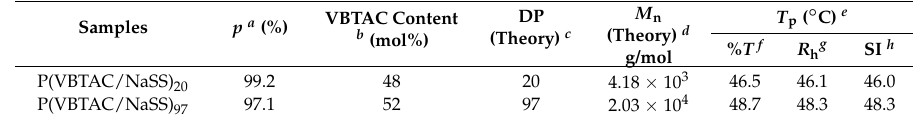
Table 1. Monomer conversion ( p ), composition, degree of polymerization (DP), number-average molecular weight ( M n ), phase transition temperature ( T p ) for the polyampholytes.